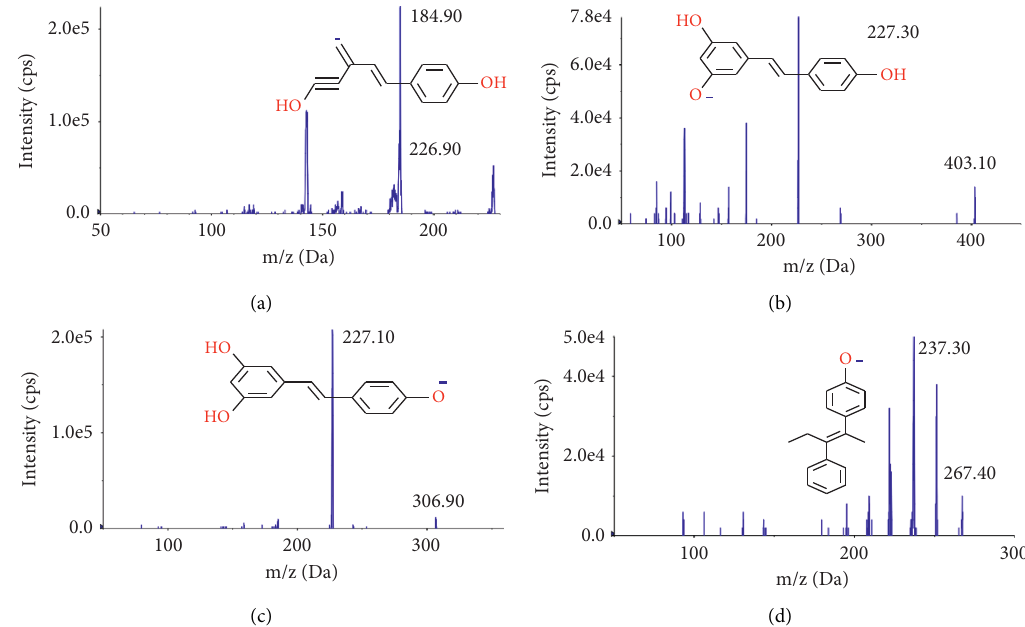
Figure 2: Product ion mass spectra of (a) trans-resveratrol (m/z 226.90–184.90), (b) trans-resveratrol-3-o- β -glucuronide (R3G, m/z 403.10–227.30), (c) trans-resveratrol-3-sulfate salt (R3S, m/z 306.90–227.10), and (d) diethylstilbestrol (IS, m/z 267.40–237.30) in negative ionization